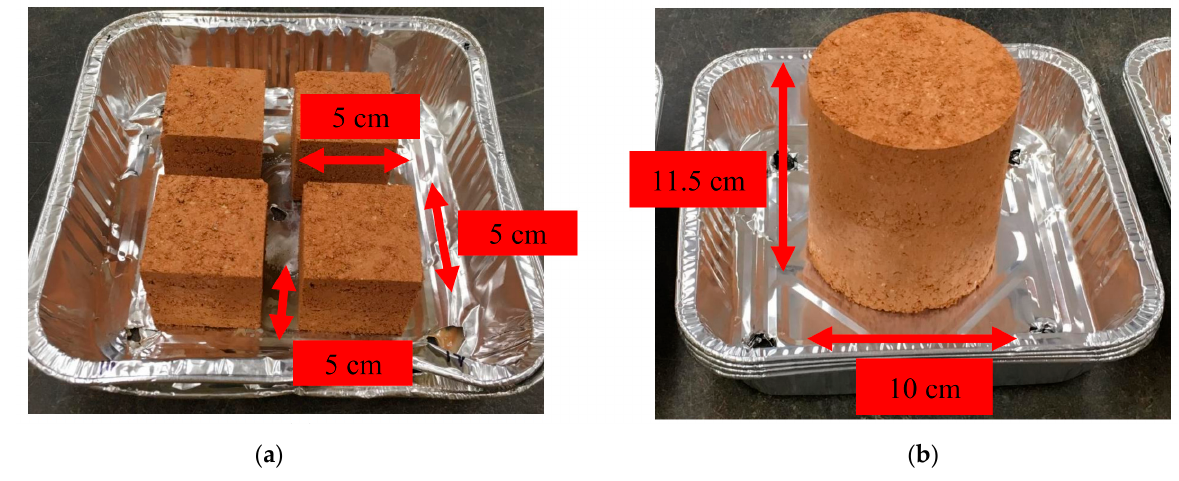
Figure 2. Photos of specimens for ( a ) unconfined compression, and ( b ) durability tests.